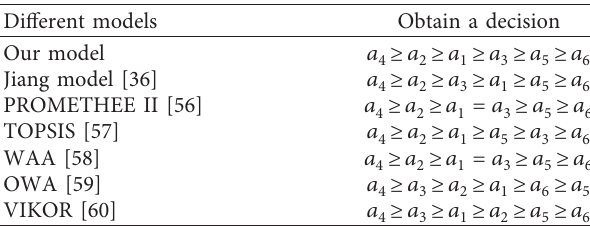
Table 5: Table for the ranking results for different methods. Different models Obtain a decision Our model